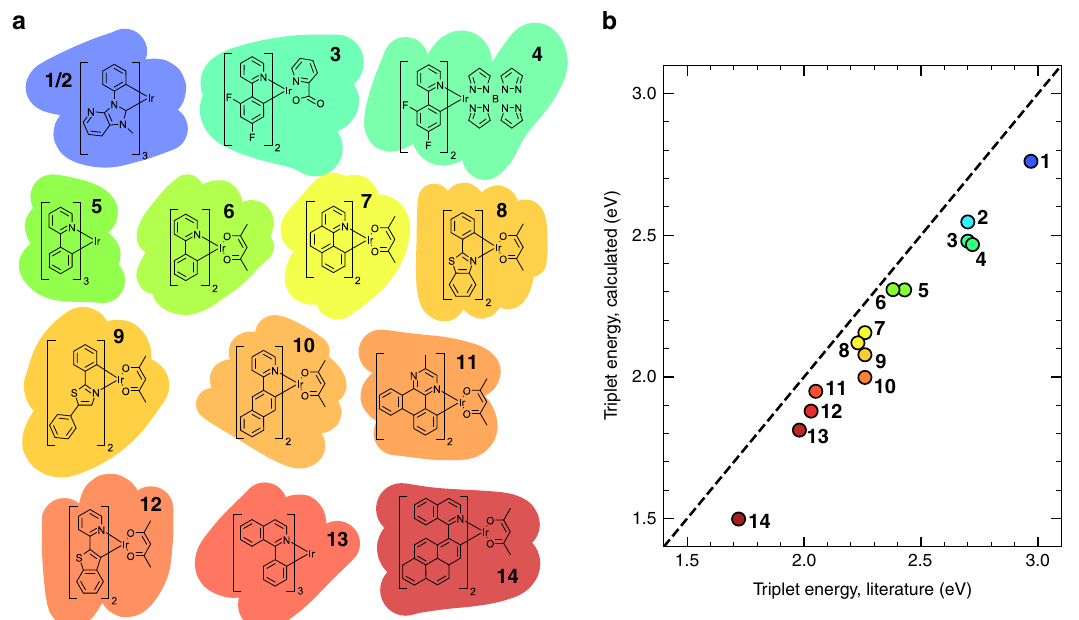
Fig. 2 Structural formulas and triplet energies of the iridium-cored emitters studied in this work. a Structural formulas of the iridium-cored emitters studied in this work. From left to right and top to bottom: Ir(pmp) 3 ( fac (1) and mer (2)), FIrpic (3), FIr6 (4), Ir(ppy) 3 (5), Ir(ppy) 2 acac (6), Ir(BZQ) 2 acac (7), Ir(BT) 2 acac (8), Ir(dpo) 2 acac (9), Ir(npy) 2 acac (10), Ir(MDQ) 2 acac (11), Ir(BTP) 2 acac (12), Ir(piq) 3 (13), and NIr (14). b Calculated triplet energies using TD-DFT (see “ Methods ” section) versus the experimental triplet energies reported in the literature. The symbol colors indicate the emission colors, ¼ E exp which range from the infrared to the deep blue. The dashed line indicates E calc . The numerical values are reported in Table T T